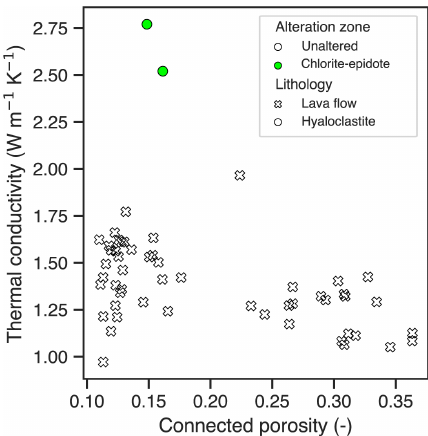
Figure 16. Thermal conductivity as a function of connected poros- ity. Note that most of the available data are derived from a sin- gle, unaltered lava flow (Guðlaugsson, 2000). Measurements on the lava flows were performed under unsaturated conditions, whereas measurements on the hyaloclastite samples were performed under water-saturated